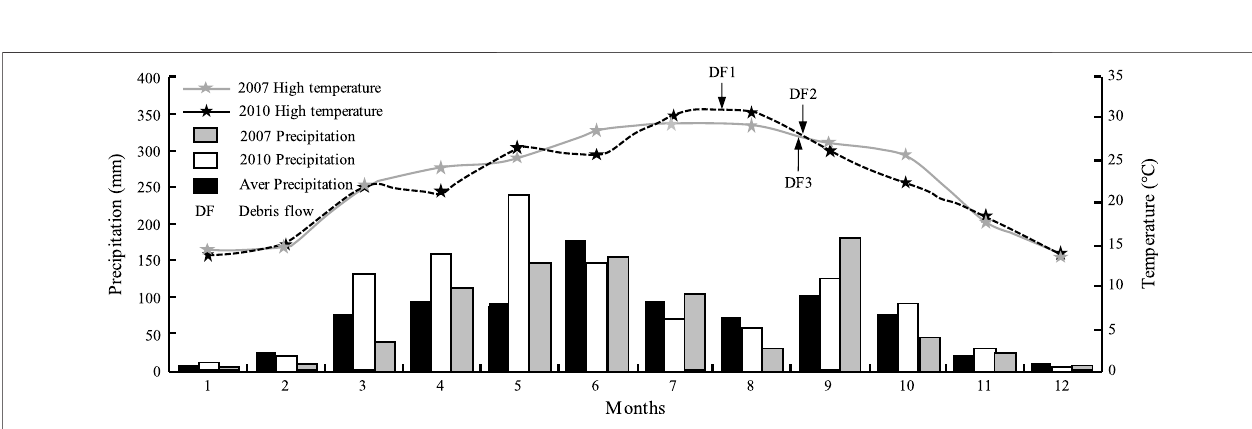
Frontiers in Earth Science |